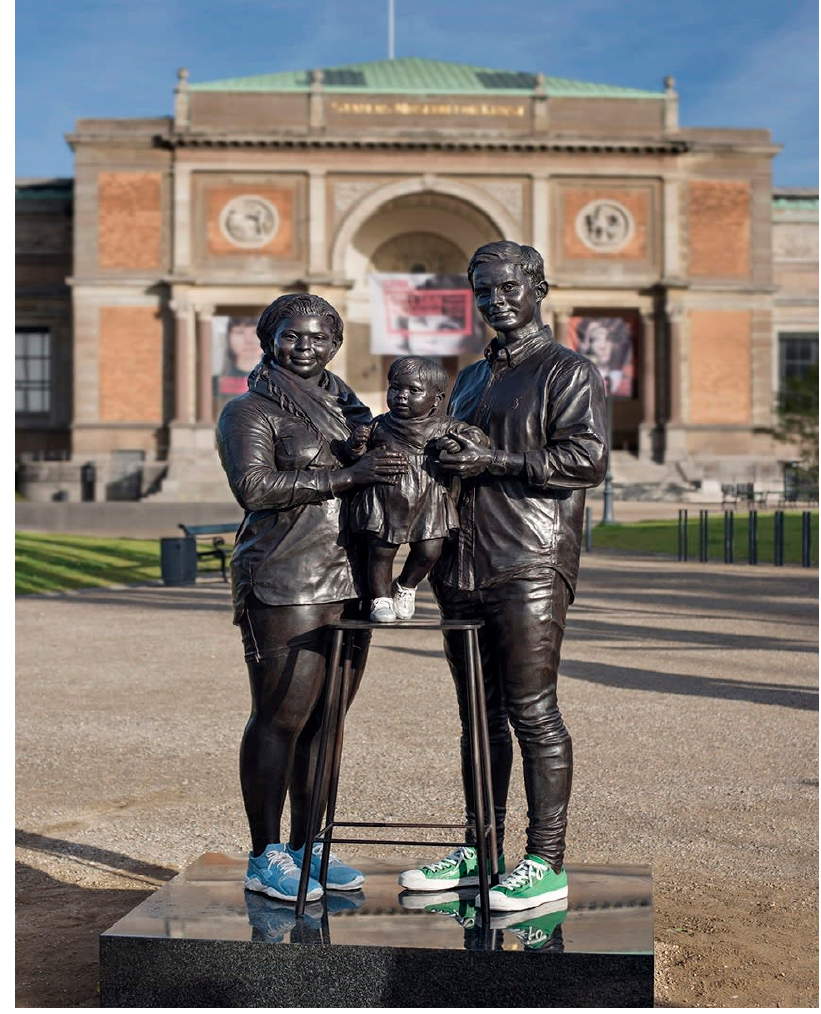
Figure 3. ‘A Real Danish Family’, 2017. Source: https://www.tanyabonakdargallery.com/artists/64-gillian-wearing/works/10301-gillian-wearing-a-real-danish-family-2017/. Photograph credited to Heine Pedersen. Accessed on 1 May 2021.